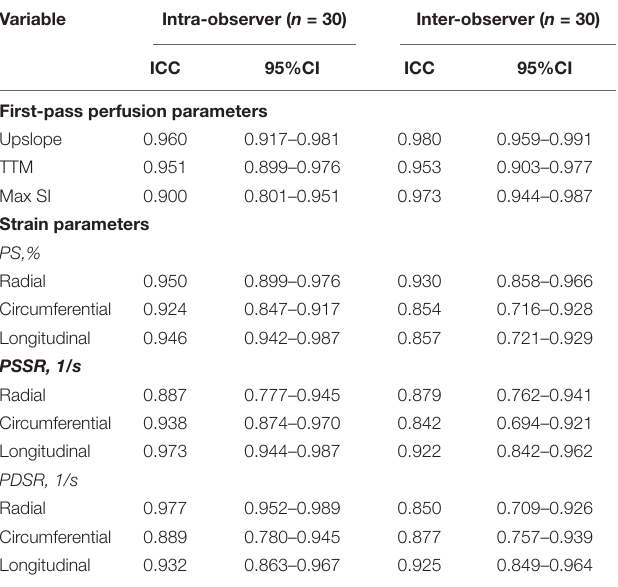
TABLE 4 | Inter- and intra-observer variability of CMR first-pass perfusion and LV strain